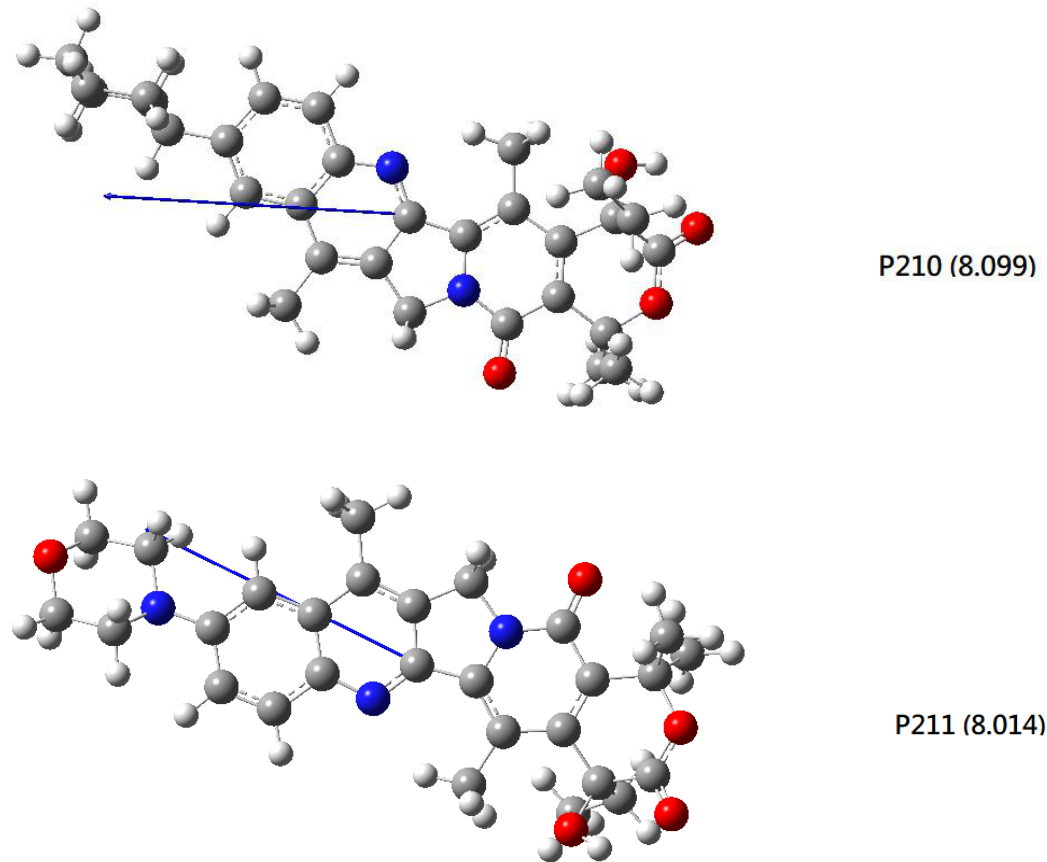
Figure 6. Compounds P210 and P211 (the values in parentheses are their respective dipole moments in Debye; carbon in gray, nitrogen in blue, oxygen in red, and hydrogen in white) .